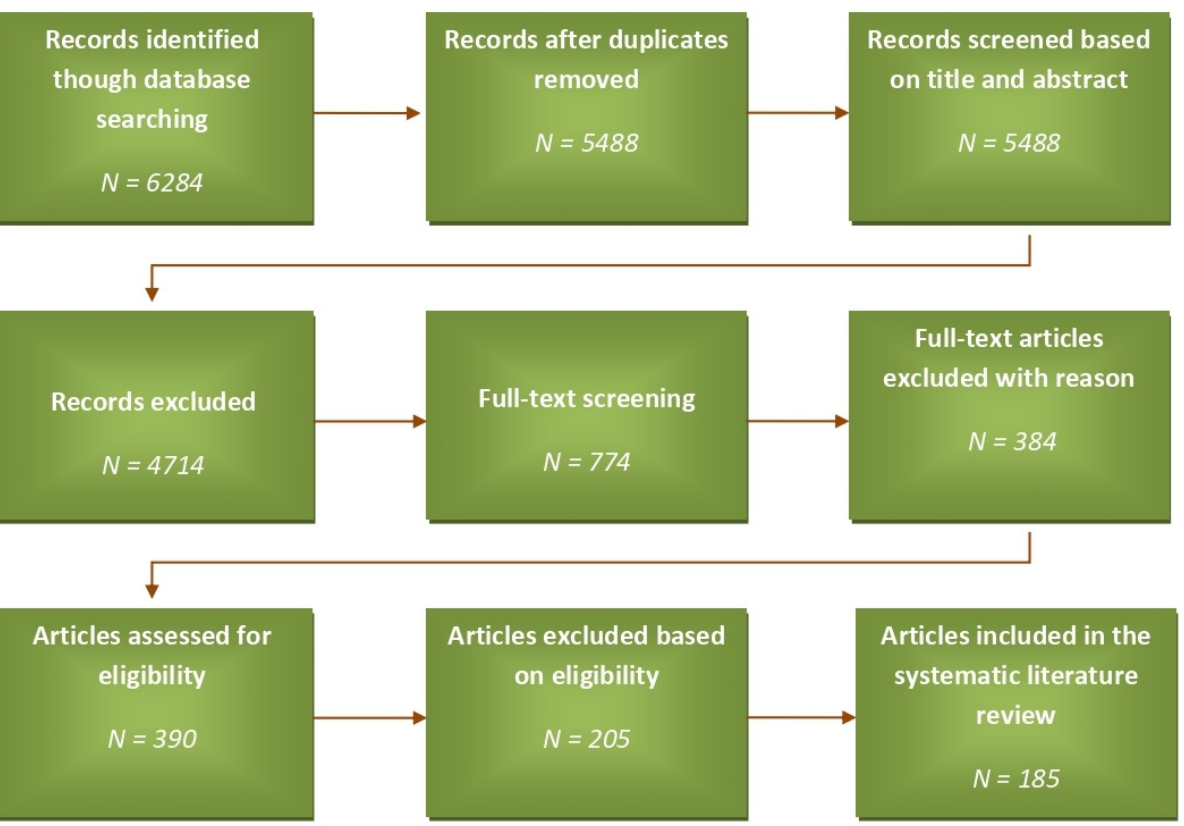
Figure 1. Literature review flowchart on the energy upgrading of hospitals .